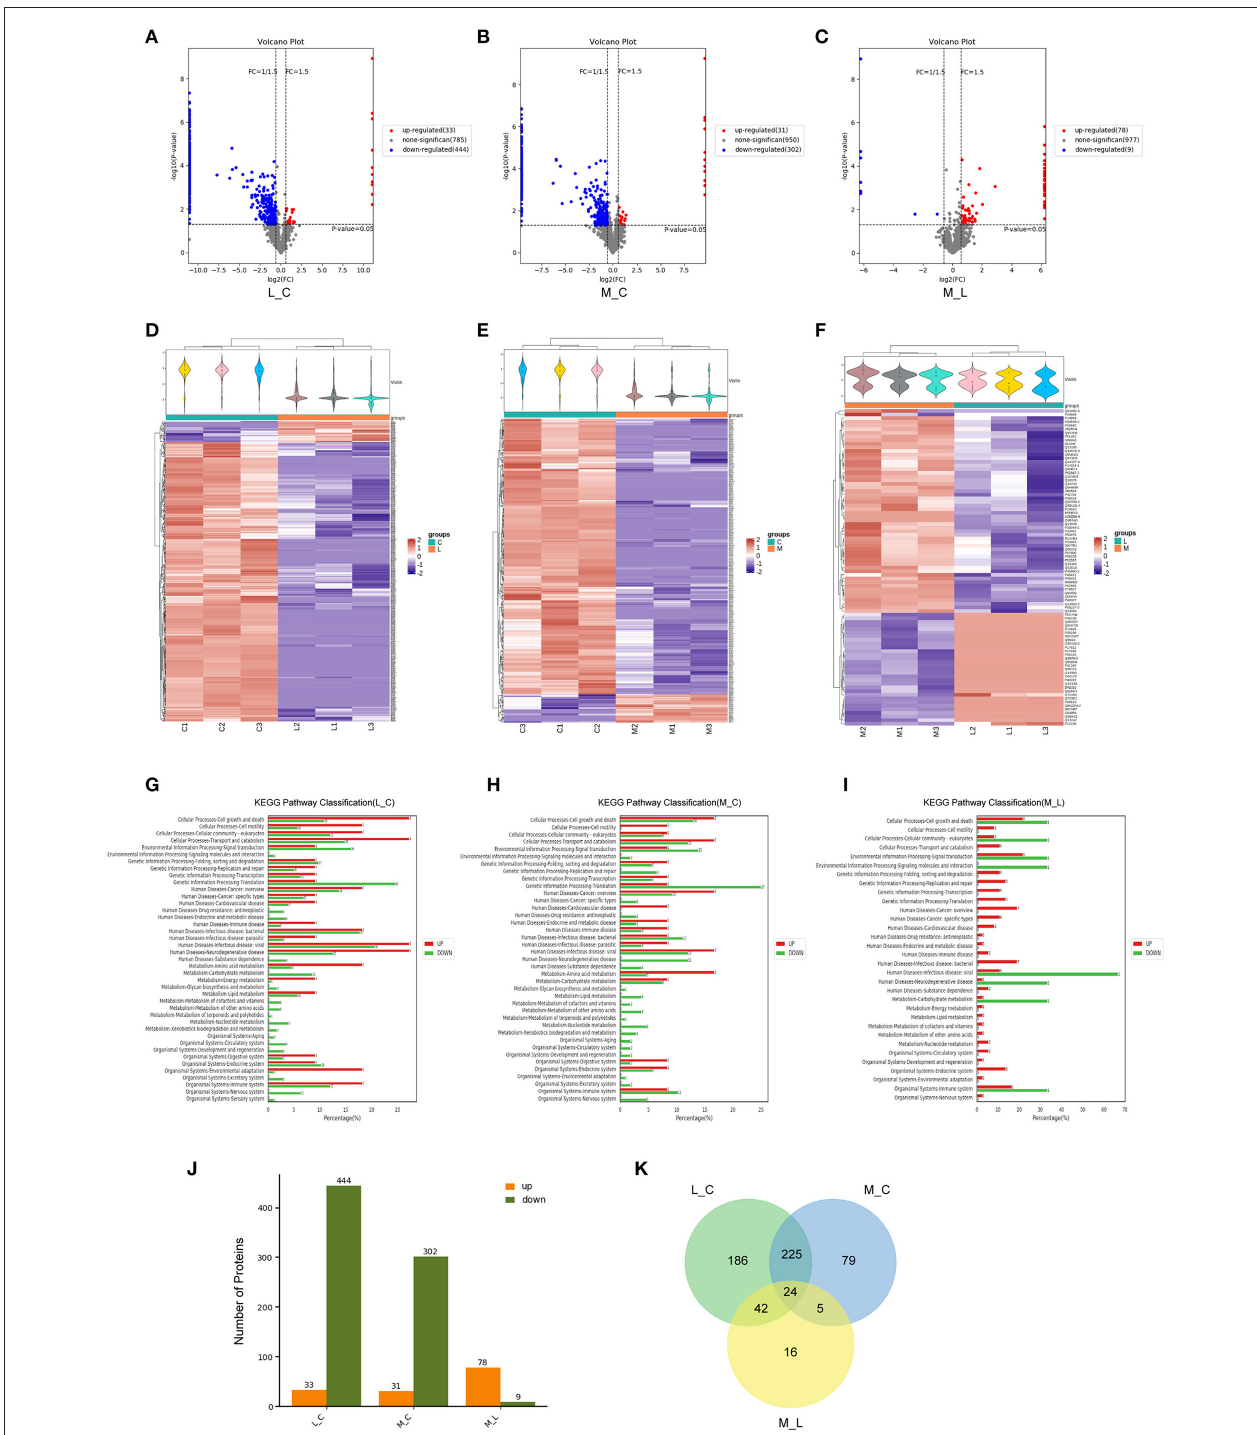
FIGURE 2 | Mass spectrometry-based proteomic analysis of cell damage caused by blue light and rescue effect of minocycline in vitro . ARPE-19 cells received blue light exposure for 2h and were further cultured for 2h before follow-up experiments. (A–C) Volcano plots of different groups. Light damage led to decrease in expression of large number of proteins, which was alleviated by minocycline. (D–F) Violin plot and clustering heatmap. Cluster analysis of protein expression in different groups. (G–I) Distribution map of upregulated and downregulated proteins at KEGG Level 2 in three groups. (J) Number of upregulated and downregulated proteins in different groups. (K) Venn analysis of characteristics and commonality of different proteins in each group. L_C, blue light group vs. control group; M_C, Blue light with minocycline group vs. control group; M_L, blue light with minocycline group vs. blue light group.